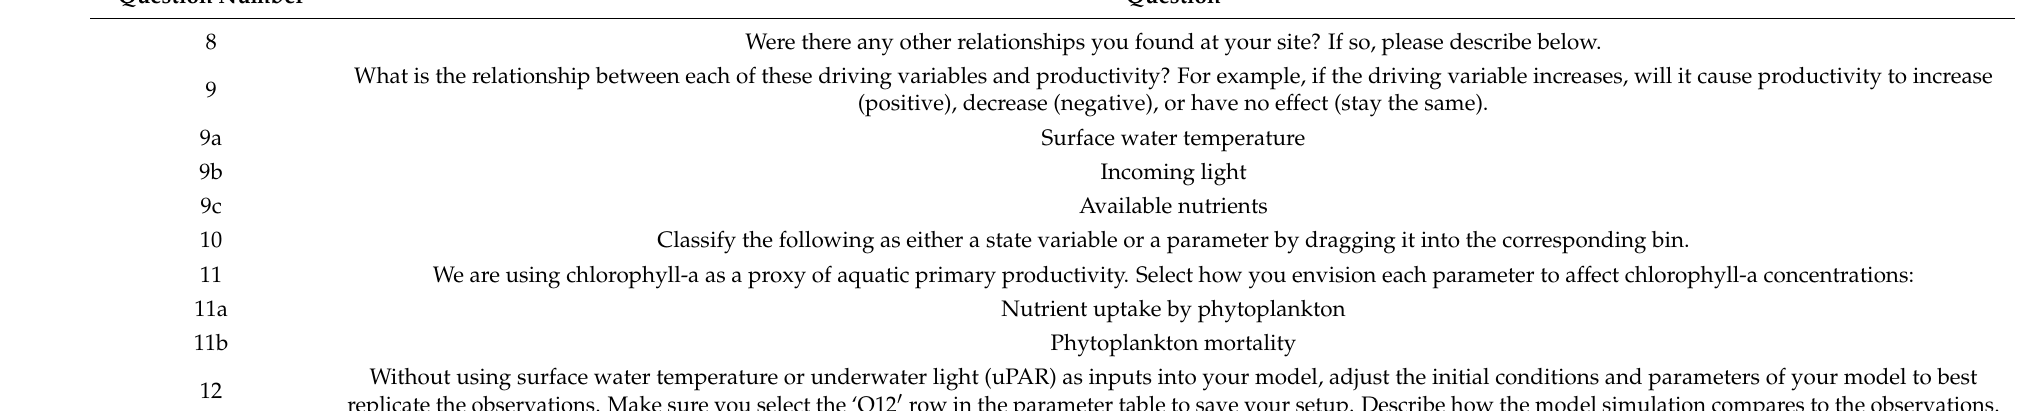
Classify the following as either a state variable or a parameter by dragging it into the corresponding bin. We are using chlorophyll-a as a proxy of aquatic primary productivity. Select how you envision each parameter to affect chlorophyll-a concentrations: Nutrient uptake by phytoplankton Phytoplankton mortality Without using surface water temperature or underwater light (uPAR) as inputs into your model, adjust the initial conditions and parameters of your model to best replicate the observations. Make sure you select the ‘Q12 (cid:48) row in the parameter table to save your setup. Describe how the model simulation compares to the observations. 13 Explore the model’s sensitivity to SWT and uPAR: Switch on surface water temperature by checking the box. Adjust initial conditions and parameters to replicate observations. Is the model sensitive to SWT? Did it help 13a improve the model fit? (Select the “Q13a” row in the Parameter Table to store your model setup there). Switch on uPAR and switch off surface water temperature. Adjust initial conditions and parameters to replicate observations. Is the model sensitive to uPAR? Did it help 13b improve the model fit? (Select the “Q13b” row in the Parameter Table to store your model setup there). Develop a scenario (e.g., uPAR is on, low initial conditions of phytoplankton, high nutrients, phytoplankton mortality is high, low uptake, etc.) and hypothesize how you 14 think chlorophyll-a concentrations will respond prior to running the simulation. Switch off observations prior to running the model. Write your hypothesis of how chlorophyll-a will respond to your scenario here: Run your model scenario. Select the “Q14” row in the Parameter Table to store your model setup there. Was your hypothesis supported or refuted? Describe what you observed: Add the observations to the plot. Calibrate your model by selecting sensitive variables and adjusting the parameters until they best fit the observed data. Save the plot and the parameters (Select the “Q15” row in the Parameter Table to store your model setup there), these are what will be used for the forecast. What is forecast uncertainty? How is forecast uncertainty quantified? Inspect the weather forecast data for the site you have chosen: 17a How does increasing the number of ensemble members in the weather forecast affect the size of the uncertainty in future weather? Which type of plot (line or distribution) do you think visualizes the forecast uncertainty best? Using the interactivity of the weather forecast plot, compare the air temperature forecasts for the first week (25 September–1 October) to the second week (2–8 October). How does the forecast uncertainty change between the two